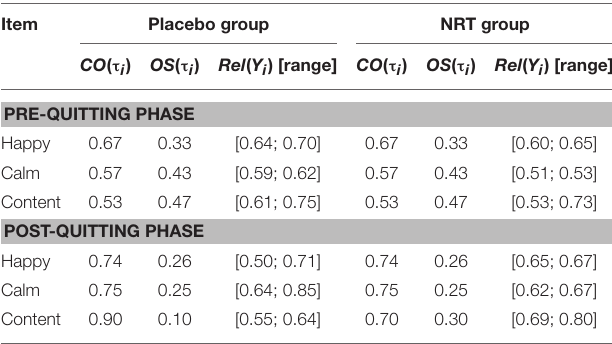
TABLE 4 | Estimates of consistency, occasion-specificity, and reliability derived from Model 15.